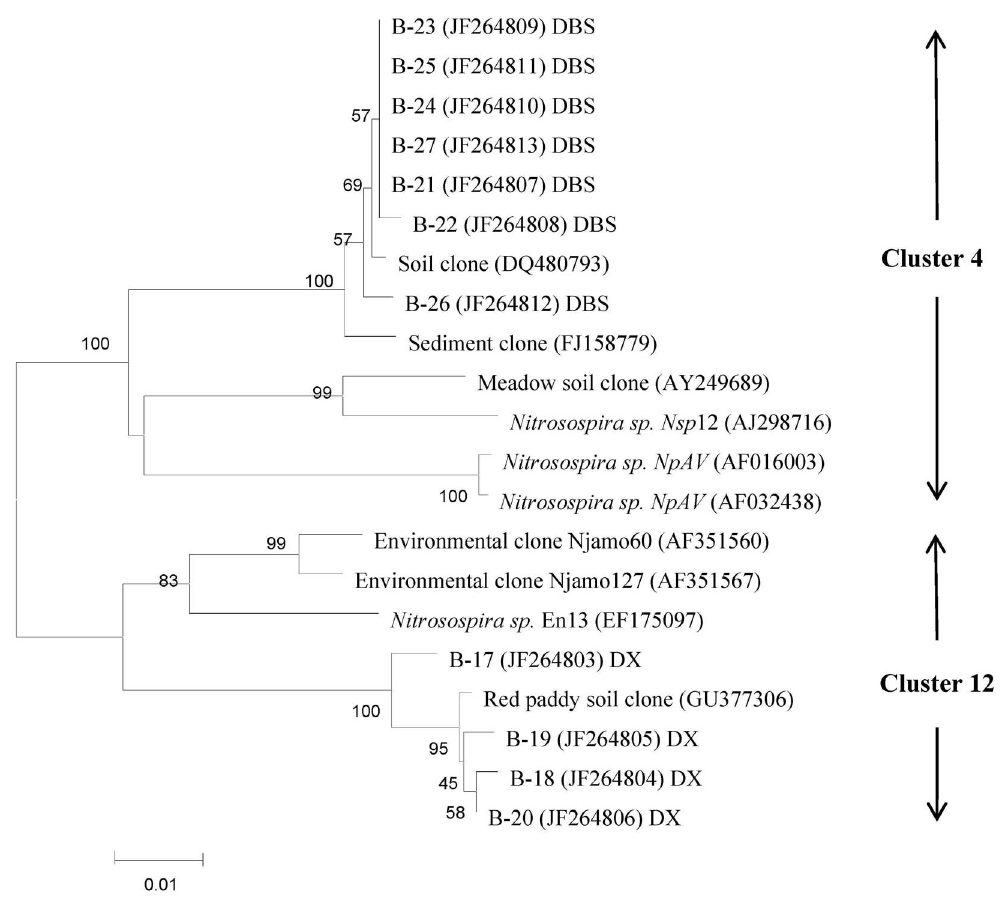
Figure 2. Neighbor-joining phylogenetic tree of AOB amoA sequences retrieved from the numbered DGGE bands of Fig. S2(A). Designation of the clones in the dashed line frames includes the following information: excised DGGE band number, accession number in the parentheses, followed by the sampling plot the clone retrieved from. Bootstrap values ( . 40%) with 1000 replicates are indicated at branch points. Scale bar indicates 1 change per 100 nucleotide positions.